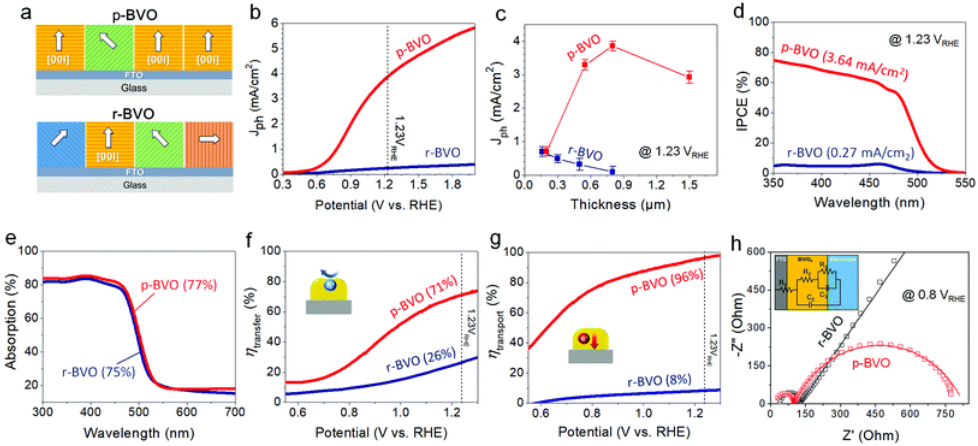
Figure 5. ( a ) Schematic representation of crystallographic orientations of preferentially oriented polycrystalline BiVO 4 (p-BVO) and randomly oriented BiVO 4 (r-BVO). ( b ) PEC performances. ( c ) Thickness dependence of photocurrent density. ( d ) IPCE. ( e ) Light absorption. ( f ) Charge transfer efficiency. ( g ) Charge transport efficiency. ( h ) Electrochemical impedance spectroscopy (EIS) spectra measured at 0.8 V RHE under simulated light irradiation (100 mW/cm 2 ). Reprinted with permission from